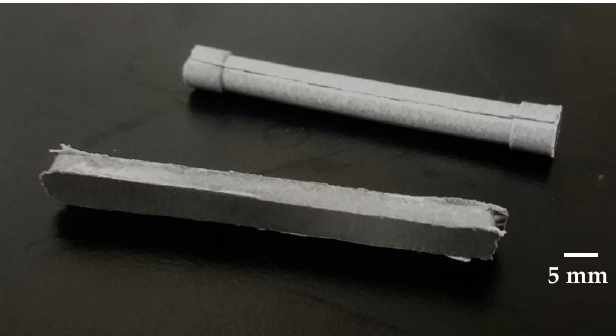
Figure 1. Picture of the composites: Cylindrical for Villari measurements and rectangular prims for measurements of microindentation.